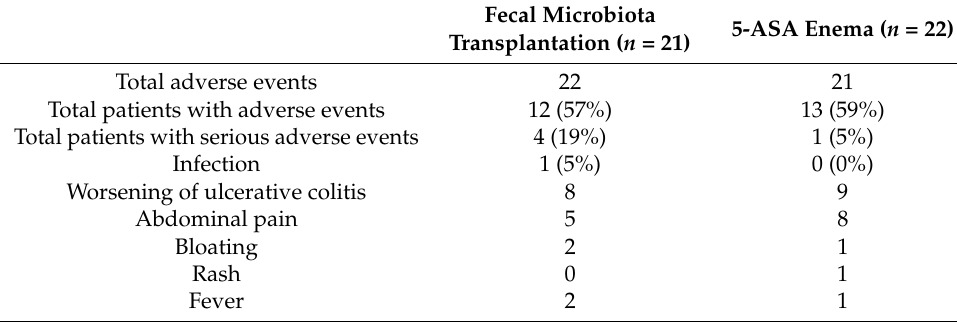
Table 3. Adverse